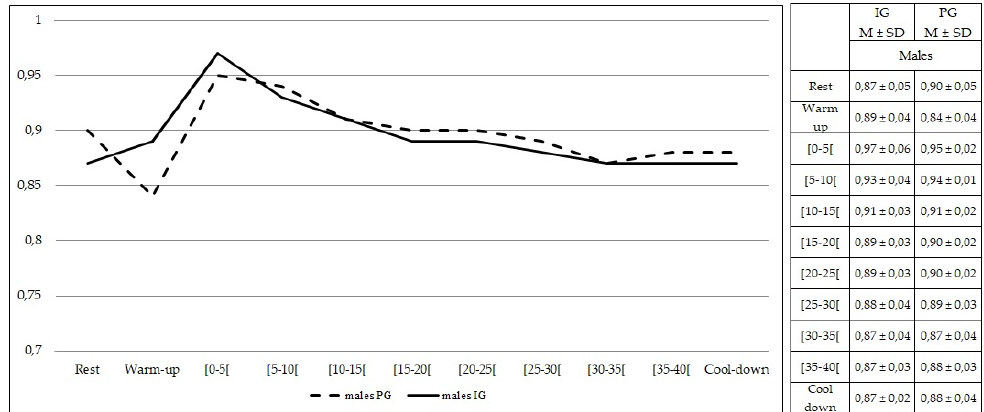
Figure 11. Respiratory exchange ratio values during rest, exercise, and cool-down in females (inter- vention group vs. placebo group). Data are expressed as mean ± standard deviation. IG: intervention group; PG: placebo group.